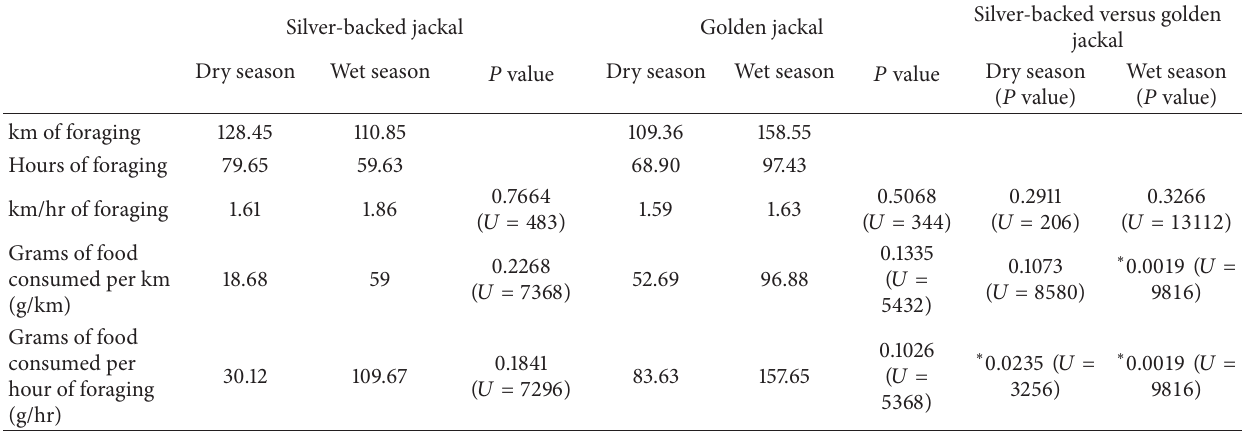
Table 1: A summary of the distance travelled per unit time (km/hour) and the foraging efficiency (weight of food consumed per km and per hour) by the two jackals species in the dry and wet